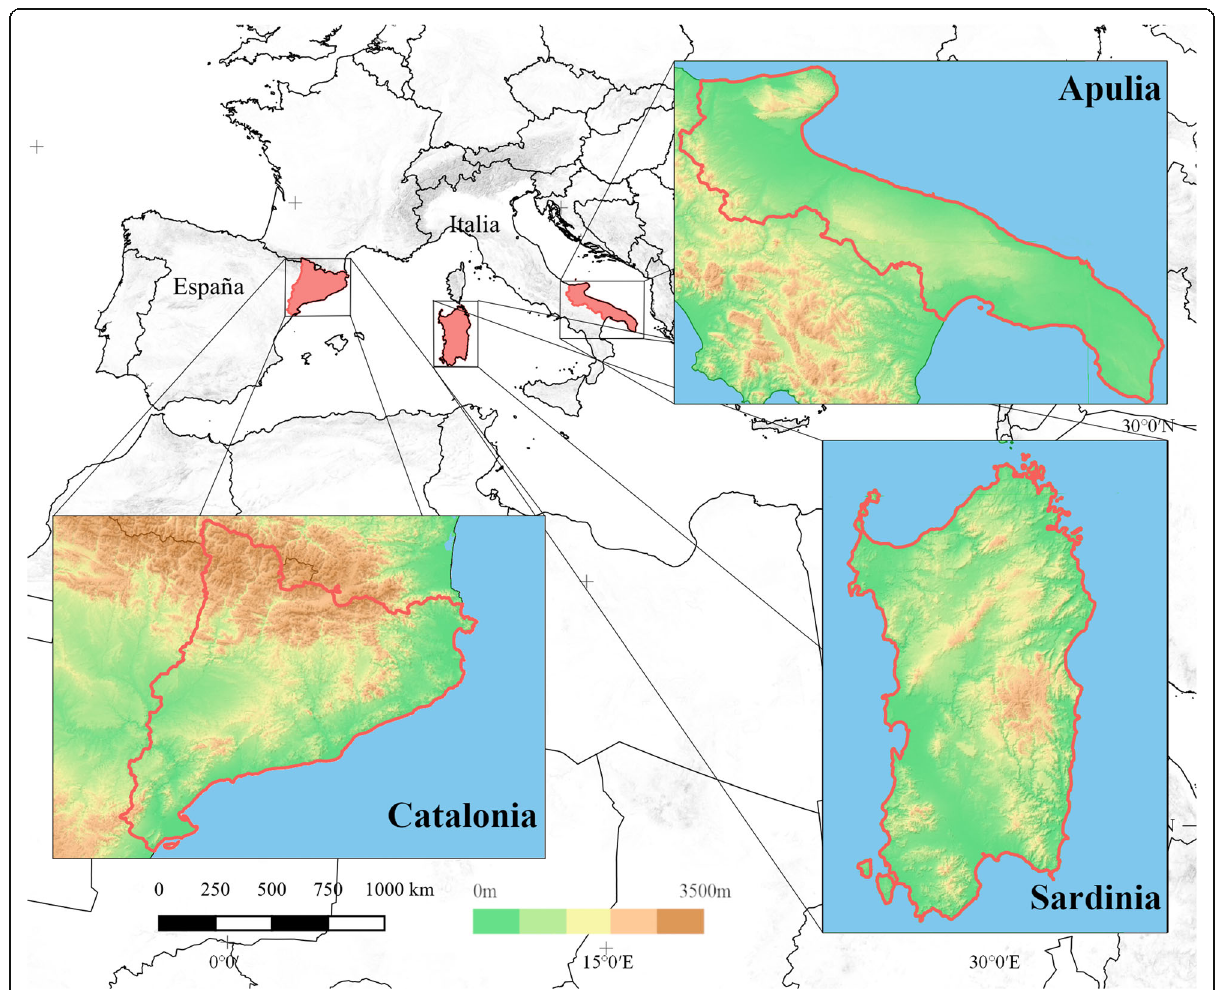
Fig. 1 Location of the study regions: Apulia, Italy (top right); Sardinia, Italy (bottom right); and Catalonia, Spain (bottom